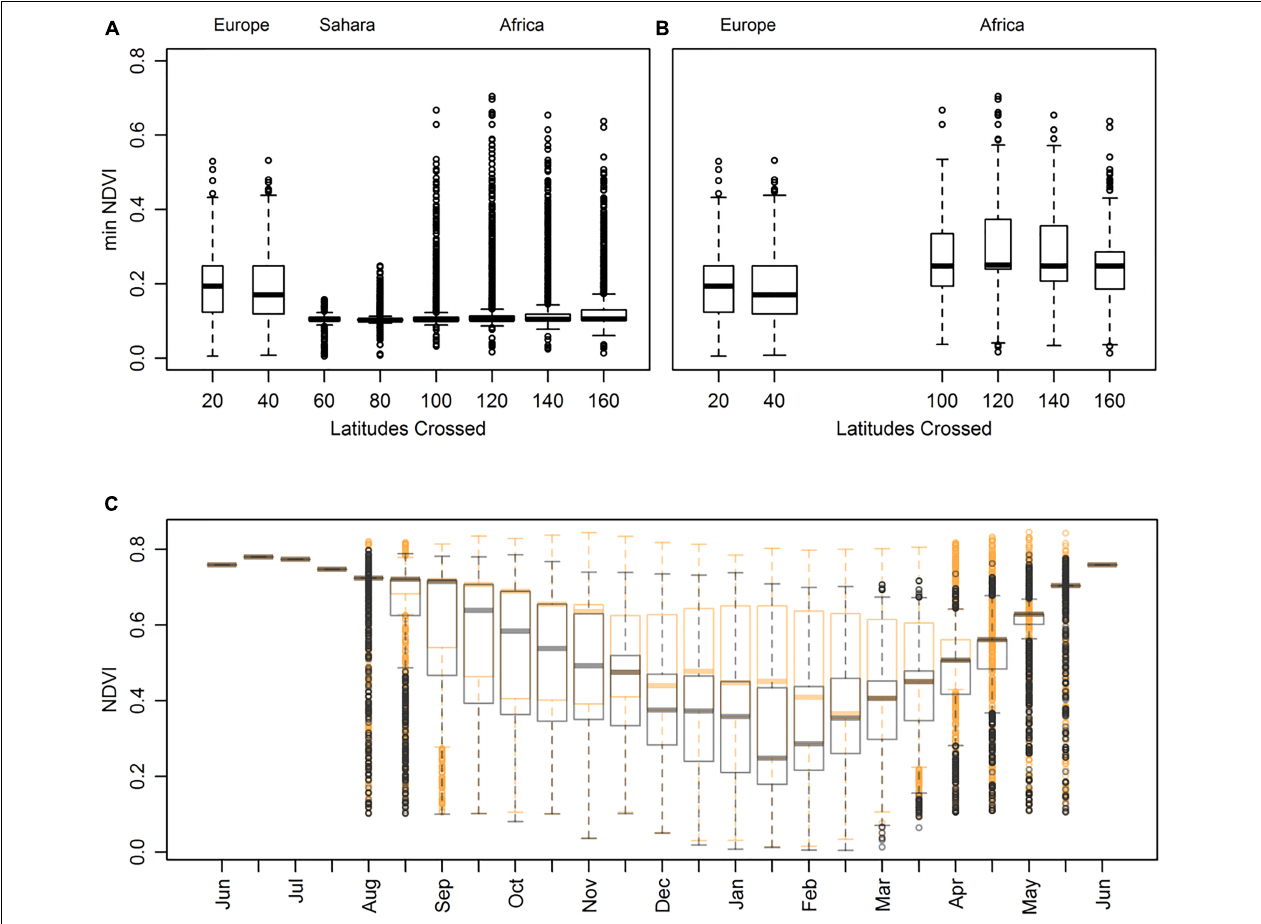
FIGURE 2 | Absolute minimum NDVI encountered over the complete round-trip for simulated tracks grouped by the total number of latitudes crossed for (A) all tracks n = 11692 and (B) only tracks that do not use the Sahara region n = 2520. Latitudes crossed are the accumulated latitudes from the breeding site to the breeding site, i.e., a track crossing 20 latitudes had a southern extent 10 ◦ south of the breeding site. Median mean NDVI for all tracks south of 40 ◦ N was 0.06 lower than tracks in Europe. (C) NDVI for tracks that did not use the Sahara region, for each temporal period. Sampled cells within Europe generally return decreasing resource values (NDVI, NPP and Surplus NDVI) with latitude (median values of 0.72, 3.39 gC m − 2 day − 1 & 1.27 at the breeding site respectively and 0.39, 1.07 gC m − 2 day − 1 & 1.06 respectively at 35 ◦ N). Latitudes with highest values NDVI and NPP during migration were located at cells between 15 ◦ S to 5 ◦ N and 15 ◦ S to 1 ◦ N in central Africa (between 0.60-0.72 and 1.61-2.32 gC m − 2 day − 1 , respectively). Tracks are partitioned by those with a southern extent in sub-Saharan Africa in orange ( n = 1220 ) and those that remained ≥ 35 ◦ N in grey ( n = 1300 ). The boxplots represent the median value and upper and lower quartiles. Whiskers represent the 95% confidence interval and outliers are shown by